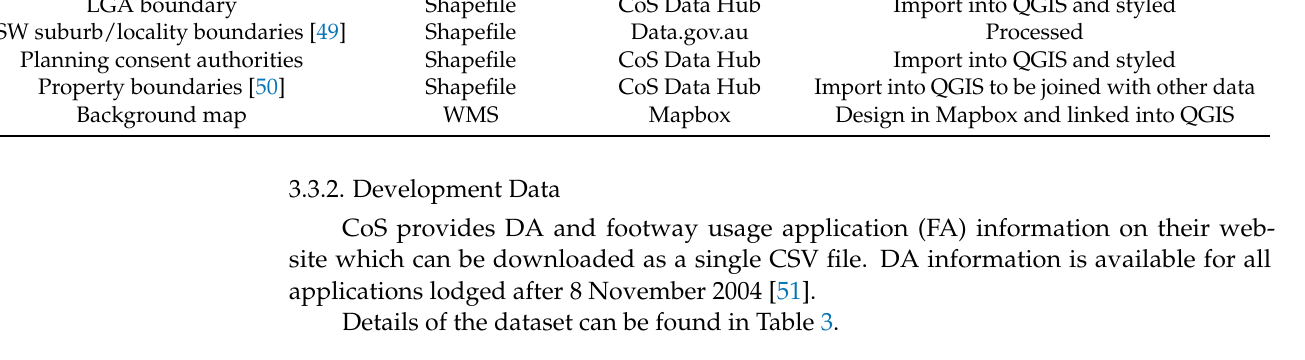
Table 3. Attributes of DA